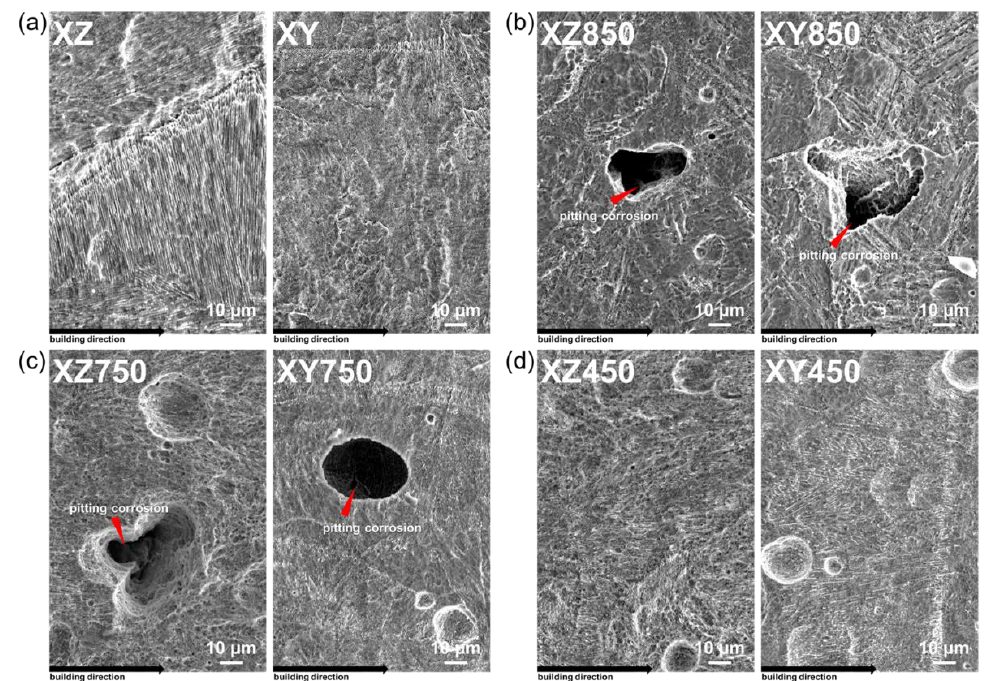
Figure 8. Corrosion surfaces of each specimen after potentiodynamic polarization test in 3.5 wt.% NaCl solution. ( a ) as-built, ( b ) 850 °C heat treated, ( c ) 750 °C heat treated, and ( d ) 450 °C heat treated.